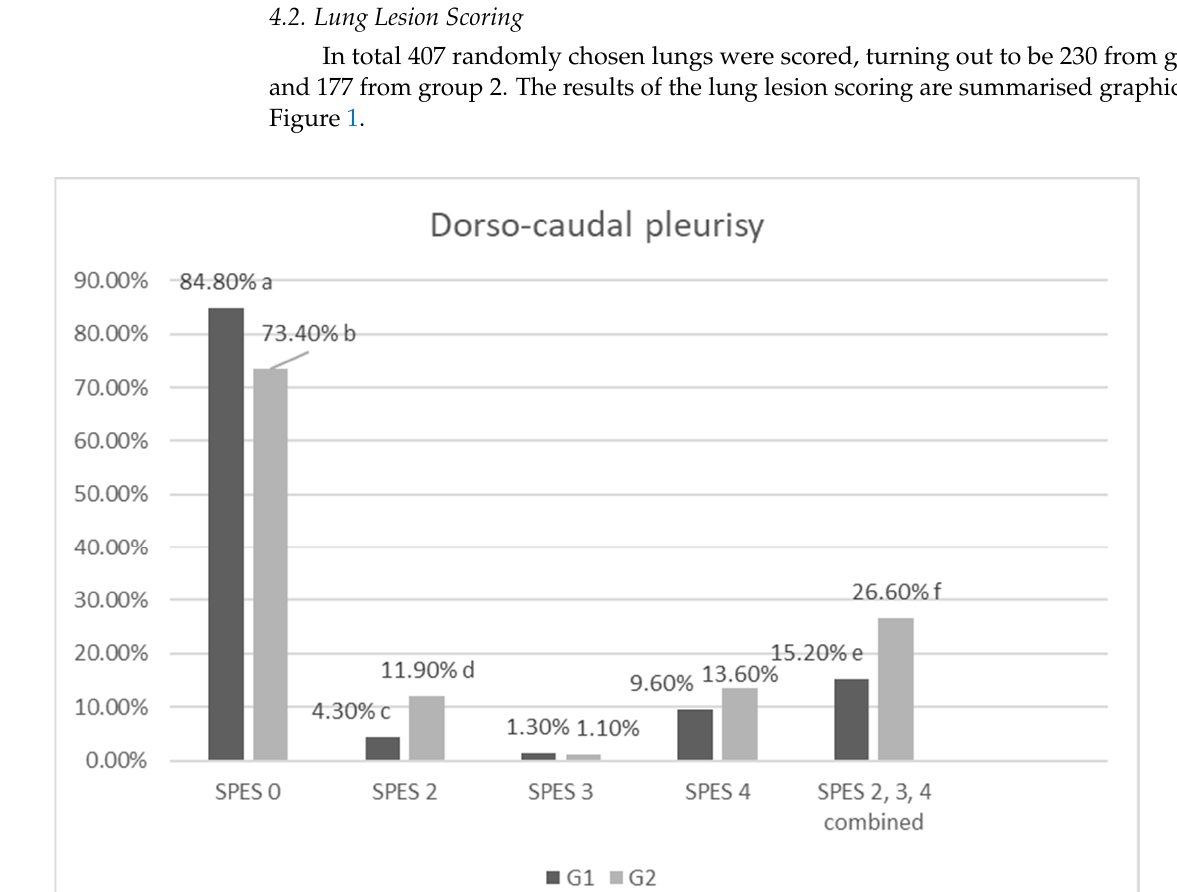
Table 1. Number of animals at the different weighing’s.